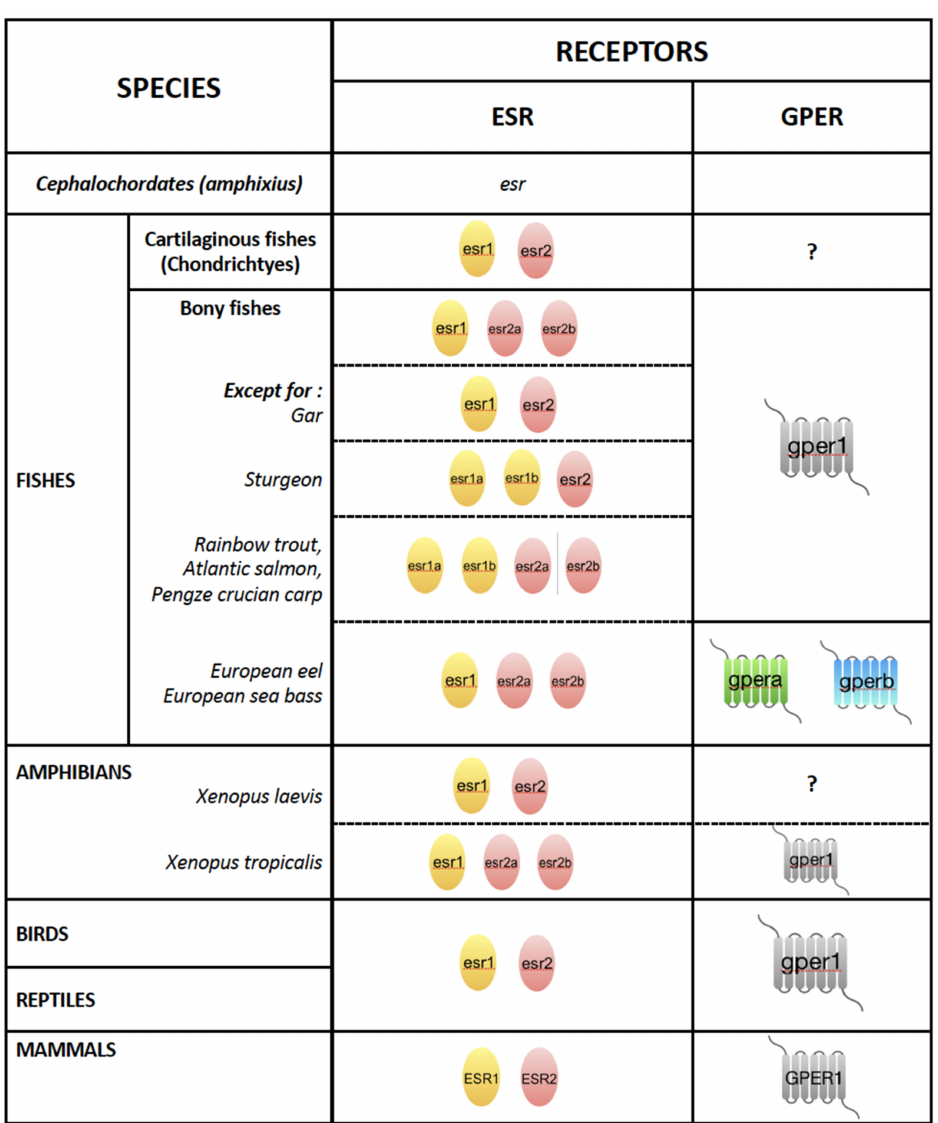
Figure 2. Occurrence of ESRS and GPERS in vertebrates. Detailed information can be found in